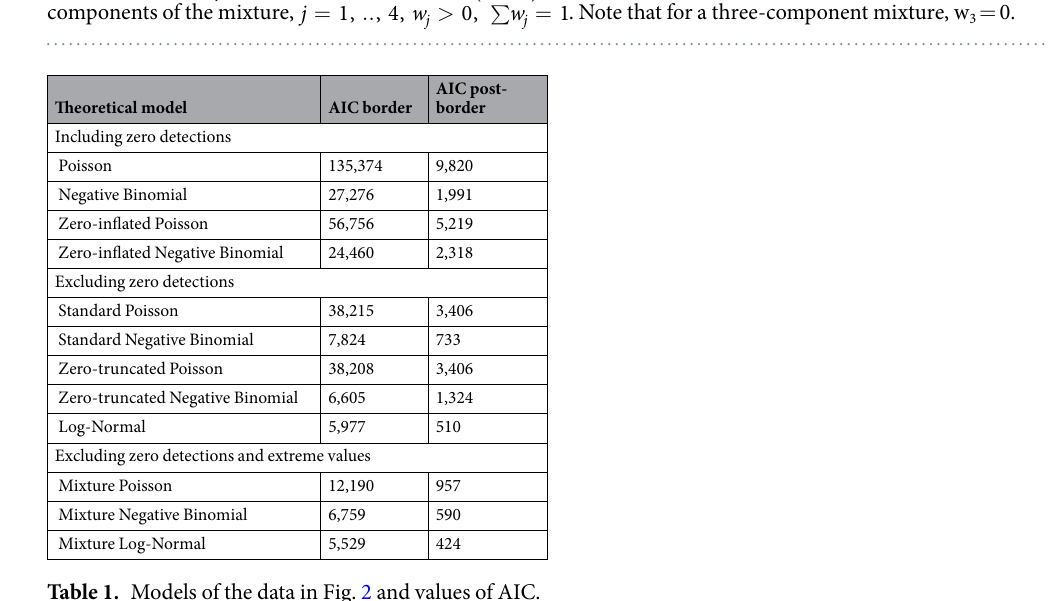
Figure 2. Frequency plot of the number of individual Non Indigenous Species found in 134,265 inspections with 1411 border detections (blue) and 141 post-border detections (red) between 2009 and 2015. Black line indicates fitted mixture distributions comprising a log-normal (LN) density for detections of less than an extreme number of organisms, and point probability masses for detections of zero organisms (I i = 0 ), single organisms (I i = 0 ) (for post-border surveillance) and extreme numbers of organisms (thresholds l of 100 and 50 for border and post-border surveillance, respectively). This last mixture component (for extreme numbers of organisms) is depicted as a uniform U( l,u) ( 0 < l < u) probability bounded by the threshold l to the modelled potential maximum number of organisms u , estimated as u = (( k + 1 )/ k )( m − 1 ), where k is the sample size and m is the sample maximum. Note that these estimates are indicative only, given sensitivity to the choice of threshold and the assumption of uniform, independent large detections. The third inset is a close-up of the fitted mixture distribution for the post-border detections of less extreme numbers of organisms. The corresponding model is given by